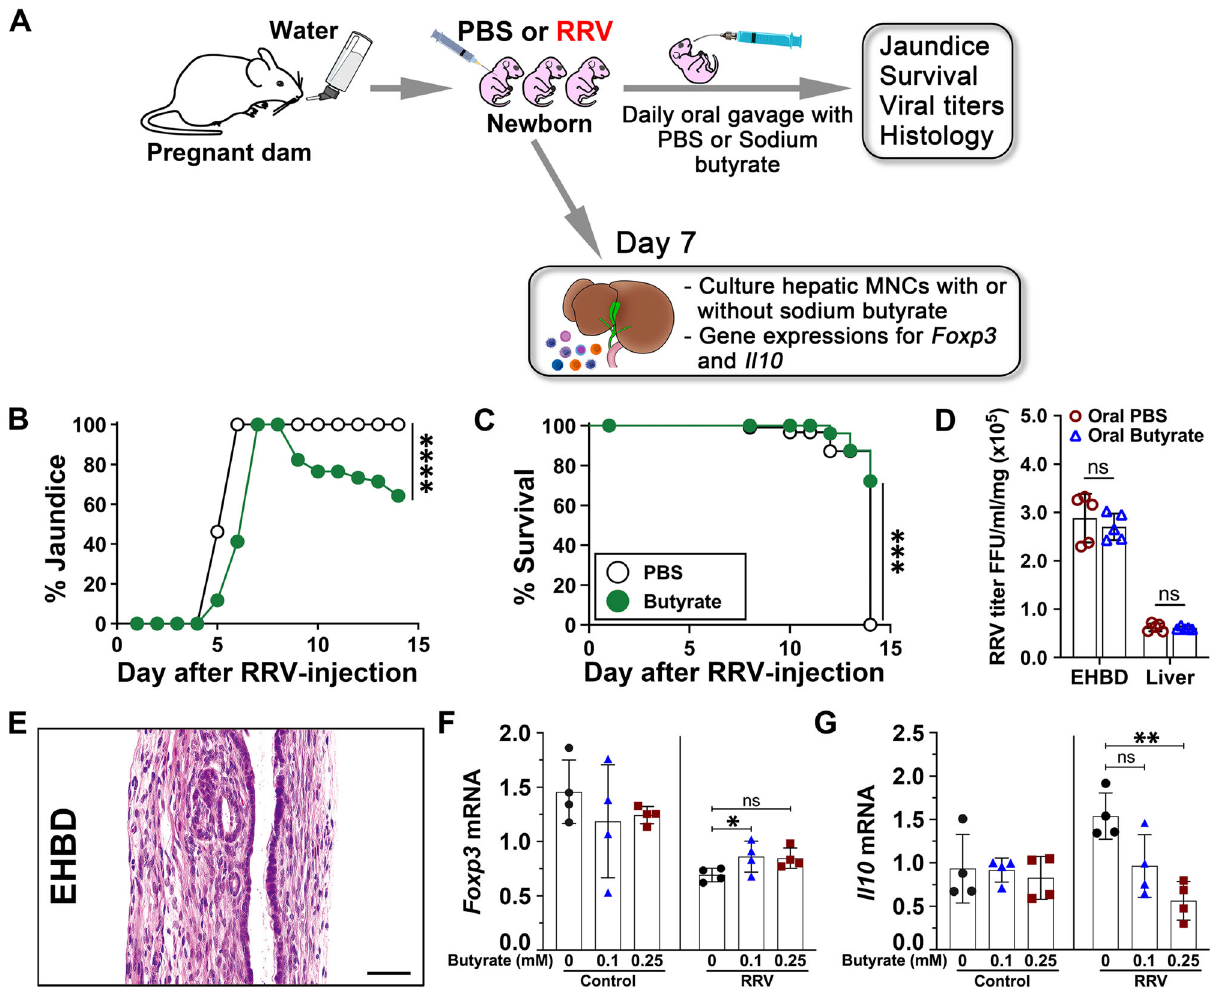
Fig. 2 Treatment of neonates with butyrate decreases hepatobiliary injury. A Diagrammatic outline of gavaging RRV-infected neonatal mice with sodium butyrate. B Jaundice (generalized linear mixed effect model with logit link and two-sided Wald test with Bonferroni correction; **** p <0.0001) and C survival (two-sided log-rank test; *** p <0.001) rates in RRV-infected newborn mice treated daily with butyrate or PBS. D Virus titers in EHBD and livers at day 7 after RRV infection of newborn mice from water-fed dams (mean±SD, two-tailed unpaired t test with Welch ’ s correction; n = 5 per group; ns = not signi fi cant) and E section of EHBD from butyrate-treated mice 14 days after RRV. In all, 15 – 30 EHBD sections (corresponding to >100 sections at ×200 or ×400 magni fi cation fi elds from n = 11 mice) stained with H&E per tissue specimen were evaluated for histology analysis. Scale bar = 50 µ M. Foxp3 ( F ) and Il10 ( G ) mRNA in RRV-naive or primed hepatic mononuclear cells cultured with or without butyrate, normalized to Gapdh (mean±SD, two-tailed ANOVA with Duncan ’ s multiple comparisons, n = 3 per group. * p <0.05, ** p <0.01, ns = not signi fi cant). Source data for this fi gure are provided as a Source data fi ducts in neonatal mice. To examine the relationship between the metabolites and the fecal microbial population, we analyzed the 16s rRNA-sequencing data of fecal microbiome from “ diseased ” and “ resistant ” subgroups using PICRUSt to quantify host gene families, MetaCyc to mine pathways, and ALDEx2 to test for differential abundance. We found an enrichment of glutamate/ glutamine, hypoxanthine/inosine, and butyrate pathways in the “ resistant ” subgroup of mice (Fig. S5). The butyrate pathways were represented by butyrate-producing Firmicutes (Firmicutes, Clostridia, Clostridiales and Ruminococcaceae ) and Bacteroidetes (Bacteroidetes, Bacteroidia, Bacteroidales, Bacteroidaceae , Bac- teroides ) taxa (Fig. S6). The bacterial genes common to these pathways were linked to molecules of the Acetyl-CoA and Lysine pathways of butyrate synthesis (Table S3).